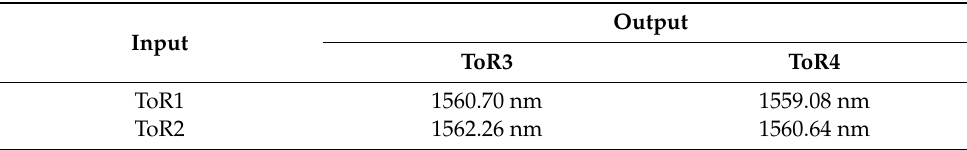
Table 3. Wavelength routing mapping of AWGR.